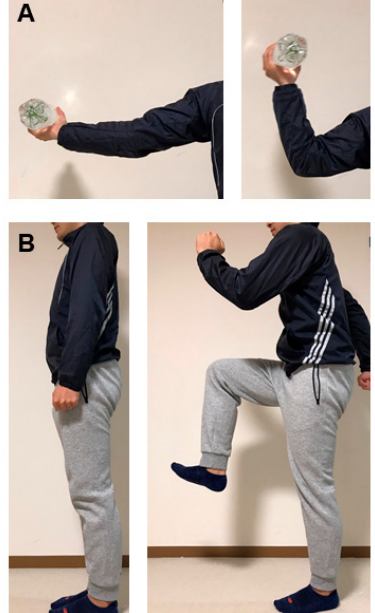
Figure 1. Suggested exercise therapy intervention for patients with uremic sarcopenia. ( A ) Biceps curl as an example of resistance training. A person holds one bottle with each hand down, raises it until it reaches his or her shoulders’ height and slowly lowers them back down after a short pause. A plastic bottle filled with water as a dumbbell can be used. ( B ) Walking in place as an example of aerobic exercise. A person lifts his or her knee up until the calf and thigh form a right angle, then, lowers that leg and repeats with the other leg. The above steps are repeated 10 times. This movement combines traditional running movements with knee lifting.